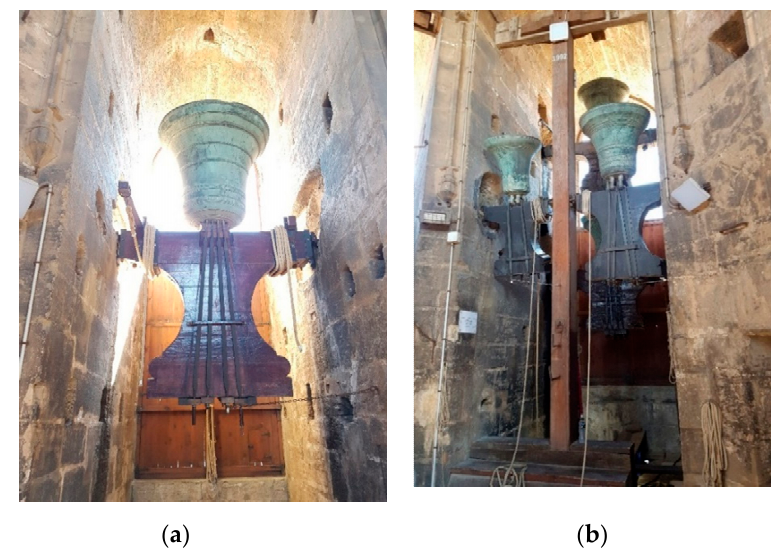
Int. J. Environ. Res. Public Health 2019 , 16 , x Figure 1. Images of the bells. (a) Single Bell. (b) Multiple bells located in one space. Figure 1. Images of the bells. ( a ) Single Bell. ( b ) Multiple bells located in one space.